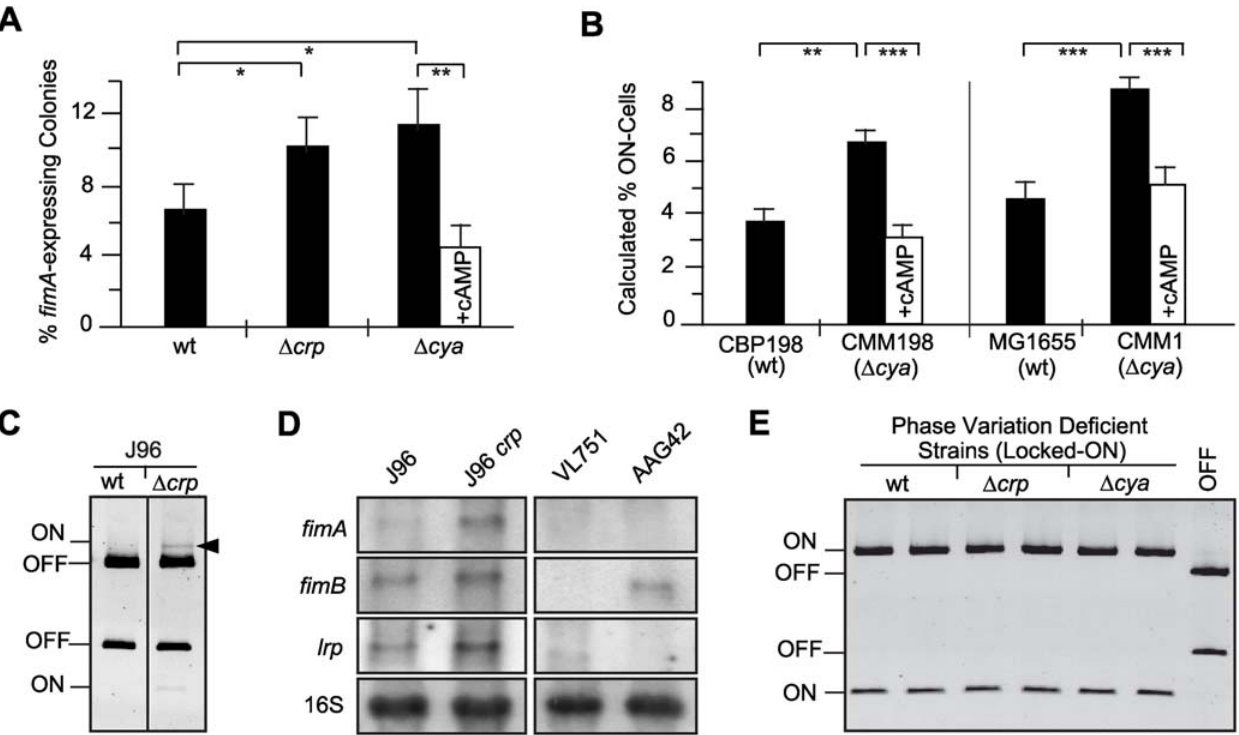
Figure 2. The percentage of fimbriated cells in the population is increased in crp and cya strains. (A) The percentage of fimA -expressing cells in presence (white bar) or absence (black bars) of 5 mM cAMP was determined by the indicator plate assay (see Materials and Methods) using mid-log phase cultures of the strains CBP198 (wt), CBP199 ( D crp ) and CMM198 ( D cya ). Mean values and standard deviations from three independent experiments are shown. (B) Quantification of the percentage of ON-cells in bacterial populations by a PCR-based assay. Cultures of wt and cya derivatives of strains CBP198 and MG1655 were grown to mid-log phase in presence (white bars) or absence (black bars) of 5 mM cAMP. Mean values and standard deviations of three independent experiments are shown. (C) ON-OFF diagnostic of mid-log phase cultures of the J96 strain and its crp derivative; the arrowhead highlights the fragment corresponding to ON-cells detected in the J96 crp samples. (D) Northern hybridization of total RNA extracted from mid-log cultures from strains J96 (wt), J96 crp ( D crp ), VL751 ( D fim ), and AAG42 ( D lrp ) with specific probes for fimA , fimB , lrp, and 16S rRNA as indicated. (E) ON-OFF diagnostic of duplicated cultures of the phase variation deficient strains CBP374 (wt), CBP375 ( D crp ), and CMM374 ( D cya ). A control showing the band pattern of an OFF population was included for comparison. The pictures in panels C and E are electronically inverted images of ethidium bromide stained acrylamide gels.